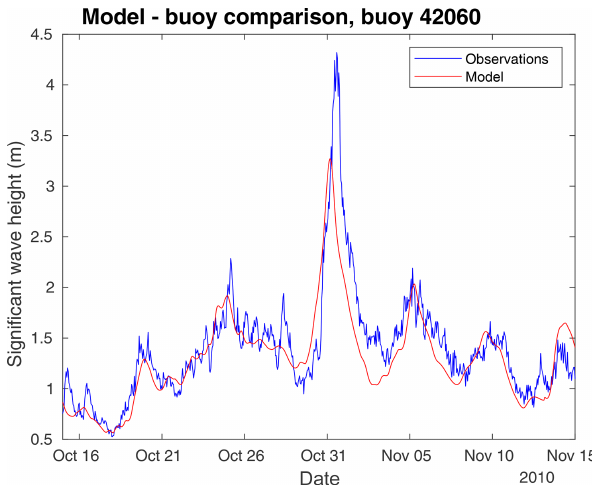
Figure 2. Time series showing a zoom to the dates of Hurricane Tomas (October 2010) from the global model and observations at buoy 42060 (see Fig. 1 for